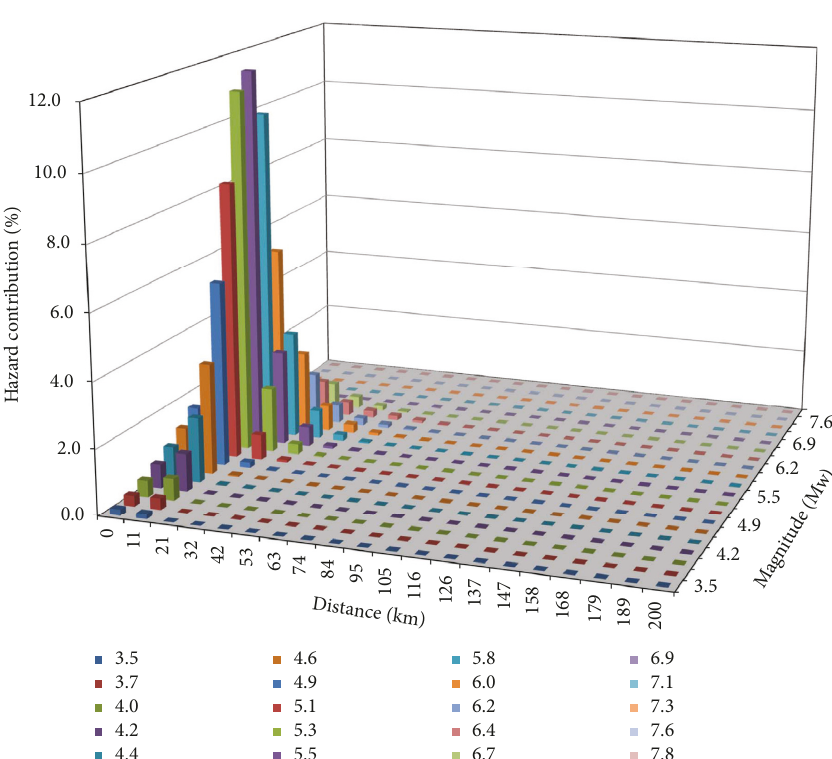
Figure 2: Deaggregation matrix for 12642years return